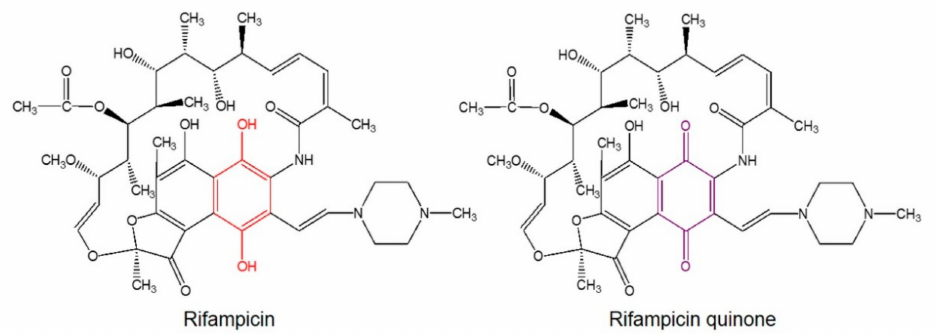
Figure 1. Rif and RifQ chemical structures. The naphthyl core structure of Rif becomes a naphtoquinone in RifQ. This signifies that the para-diphenol (red) of the naphthyl core is converted into a para-quinone